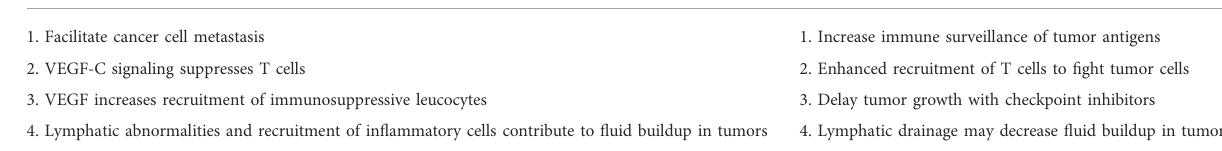
TABLE 1 The different negative and positive views of lymphatics that contribute to the relationship between cancer and